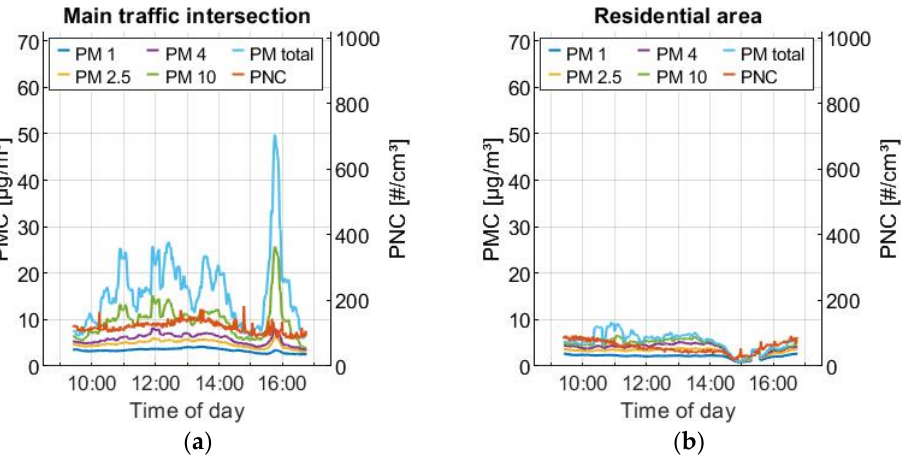
Figure 8. Defined measurement positions for assessing particle pollution in different environments [Source: Google Earth, GeoBasis-DE/BKG (©2009)].